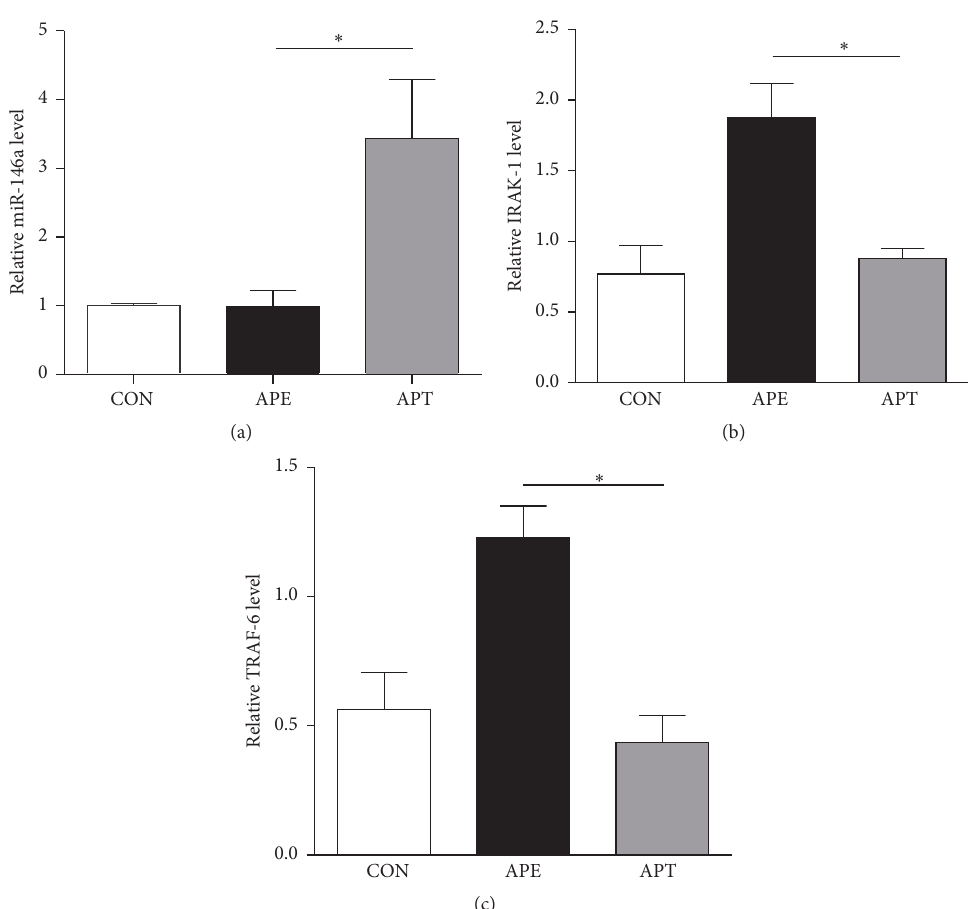
Figure 3: Relative levels of miR-146a and its target mRNAs 2 h after pilocarpine administration by real-time qPCR. (a) In comparison with the APE group, the relative level of miR-146a increased 3.42 times in the hippocampus of the APT group. ((b) and (c)) The expression of its target mRNAs IRAK-1 and TRAF-6 reduced 0.46 and 0.36 times in the hippocampus of the APT group compared with the APE group, respectively. Values are presented as the means ± SD ( ∗ 𝑝 < 0.05